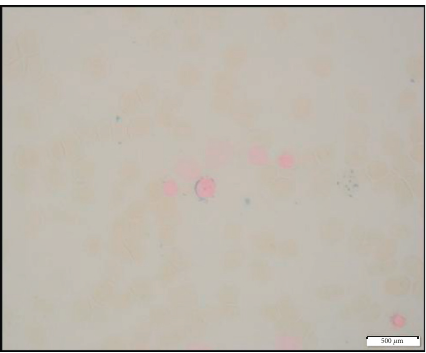
Figure 3: Iron staining before treatment showing increased storage and sideroblastic iron with few ring sideroblastic iron.